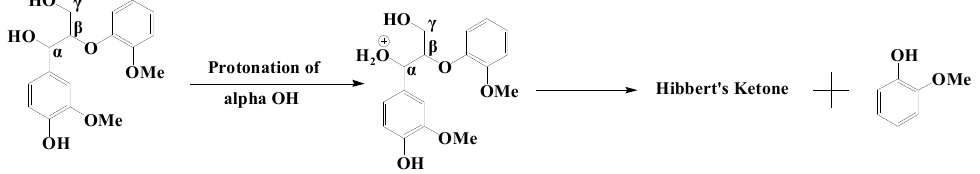
Figure 5. Mechanism of β -O-4 ether link cleavage of lignin compounds [45].